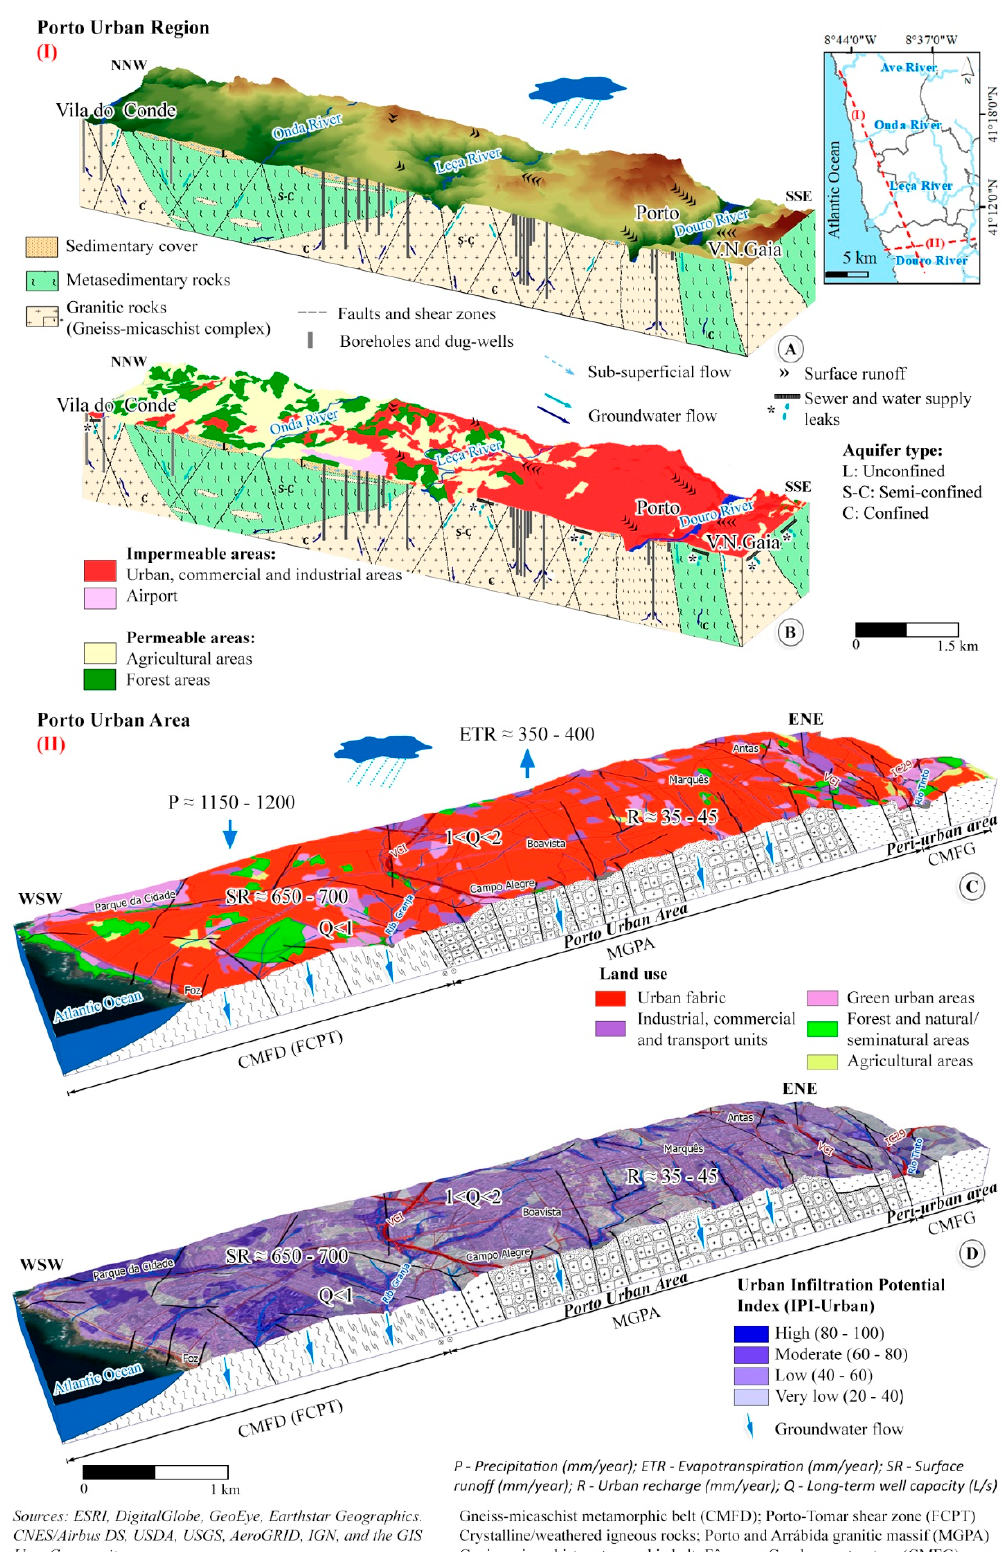
Figure 9. Urban hydrogeological conceptual models (revised and updated from [61,114]. ( I ) Porto urban region: ( A ) Pre-urban scenario; ( B ) Urban scenario). ( II ) Porto urban area: ( C ) Land use context; ( D ) IPI-Urban framework.